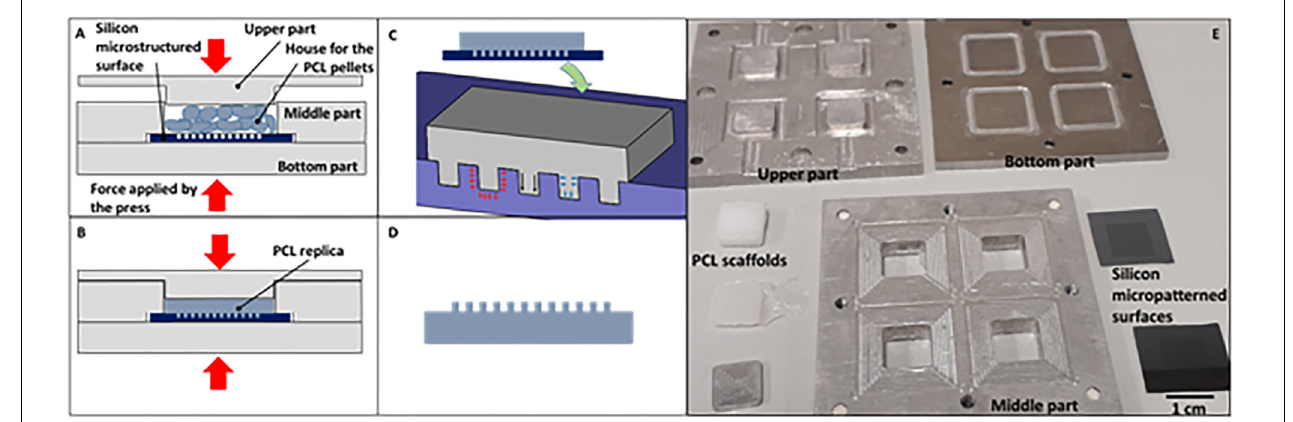
FIGURE 1 | Scheme of the aluminum mold and the hot embossing (HE) process: (A) heating up of the aluminum mold and the PCL pellets; (B) hot embossing of the PCL replica; (C) cooling down of the PCL replica and the silicon microstructured substrate [the tensions acting between the replica and the mold due to adhesion (red arrows), friction (black arrows), thermal expansion (blue arrows) are also reported]; (D) PCL replica removed from the mold; (E) Picture of the different part composing the aluminum mod and PCL